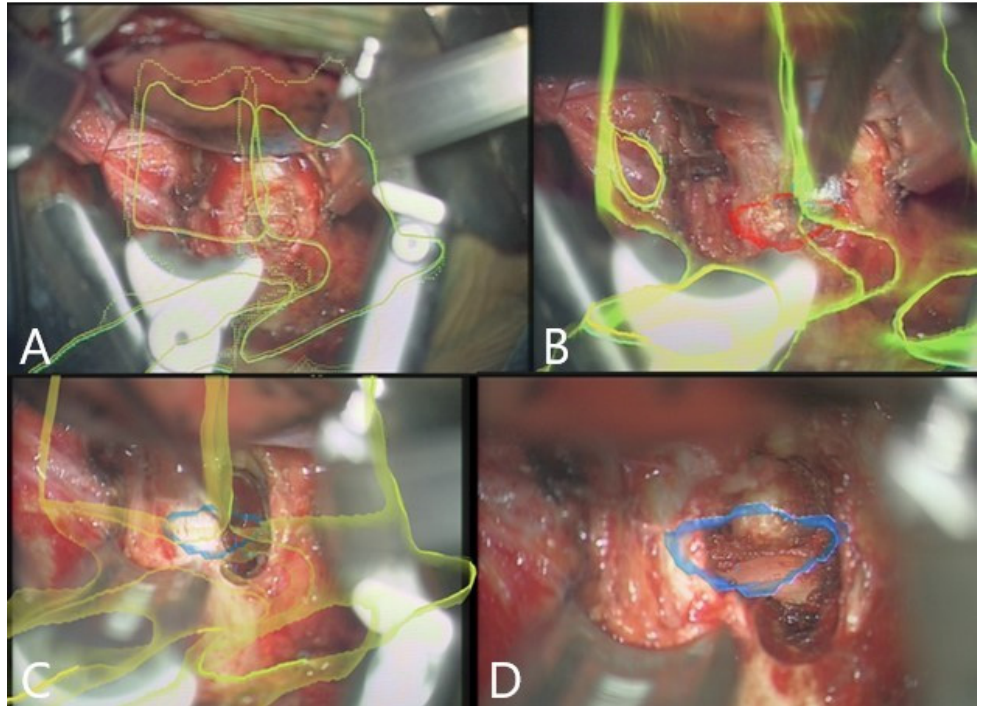
Figure 3. AR microscope view during the course of the surgery (same patient as in Figure 2). In yellow, the 3D outlines of the vertebra and in blue the segmented disc herniation are visualized by the HUD. ( A ) After retractor placement. ( B ) Removal of the sequester with a rongeur. ( C ) Mobilization of the disc fragment with the hook. ( D ) Following removal of the sequester, visualization of dura with outline of the extirpated disc.